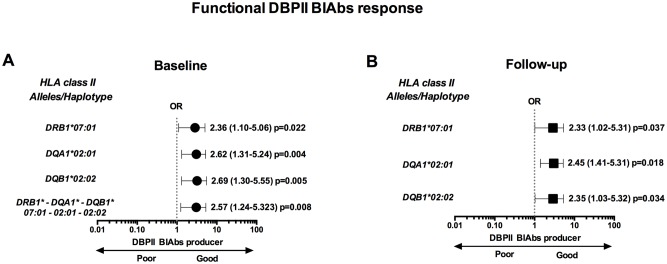
Association between HLA class II alleles (DRB1, DQA1, and DQB1 loci) and Plasmodium vivax Duffy binding protein (DBPII) binding Inhibitory Antibodies (BIAbs) in individuals naturally exposed to malaria.(A) At enrollment (baseline), Odds Ratio (OR) analyses for the association of HLA class II (alleles and haplotypes) and DBPII BIAbs response, as detected by functional assays with DBPII- transfected COS cells; black circles represent alleles and haplotypes of HLA class II associated with a positive BIABs response. (B) After 12-month follow-up, Odds Ratio analyses for the association of HLA class II (alleles and haplotypes) and long-term DBPII BIAbs response; individuals were classified as persistent non-responder (PNR) or responder (PR, black square), as described in legend of Fig 2. Odds Ratio analyses realized using standard contingency tables (p < 0.05; qui-square and Fisher’s exact test, as appropriate).